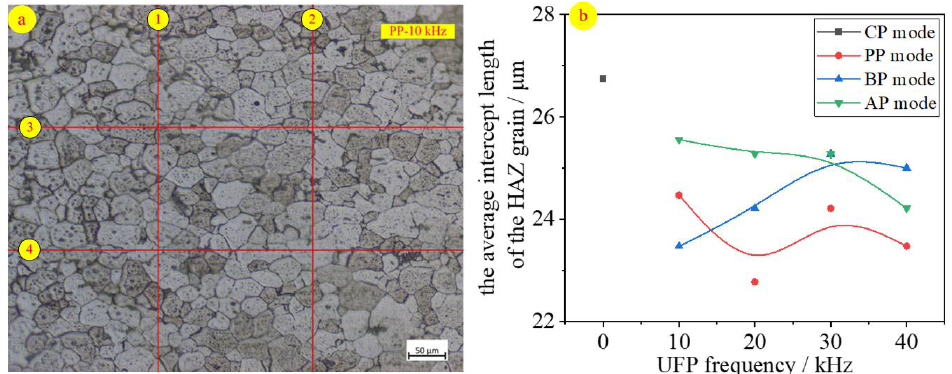
Figure 7. The average intercept length of HAZ grain, lineation method ( a ), value of different modes and frequencies ( b ).